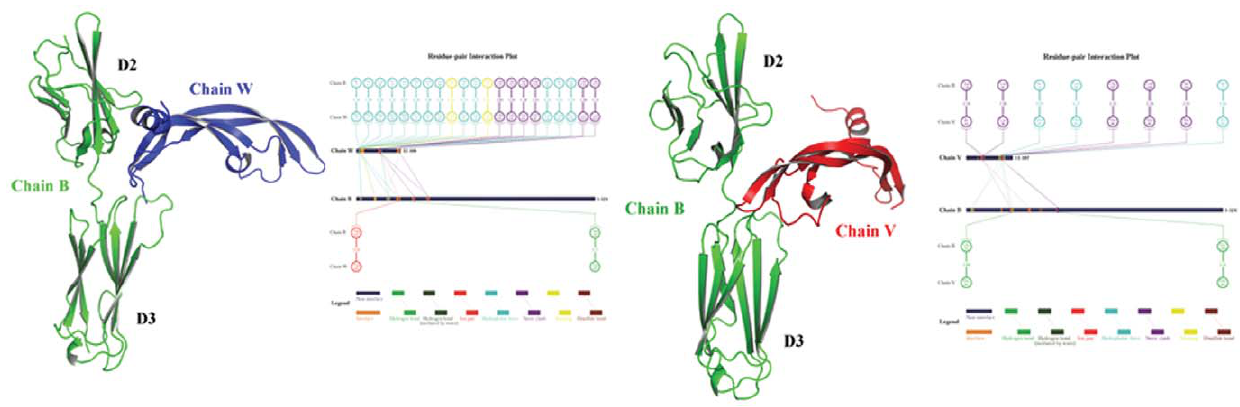
Figure 6. Schematic representation of diverse nonbonded interactions across the complex interface of VEGF-A chains W and V separately with conbercept chain B. This figure was prepared with the in-house program 2D-Gralab [51].